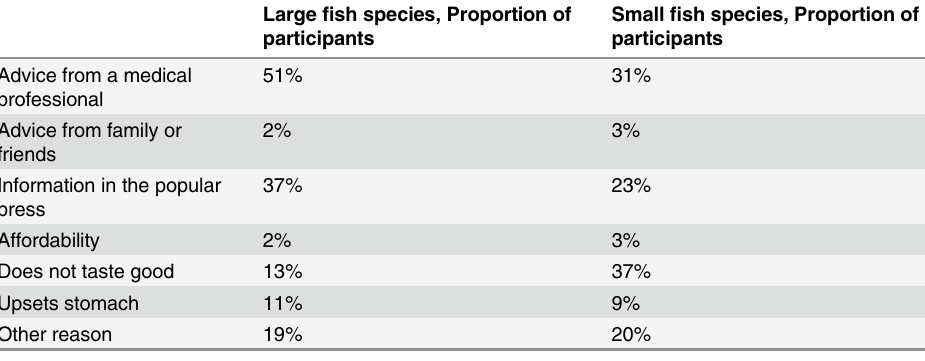
Table 2. Reasons given by study participants for reducing the consumption of large and small fish species, from among those who reported reduced consumption of these species since becoming pregnant 1,2